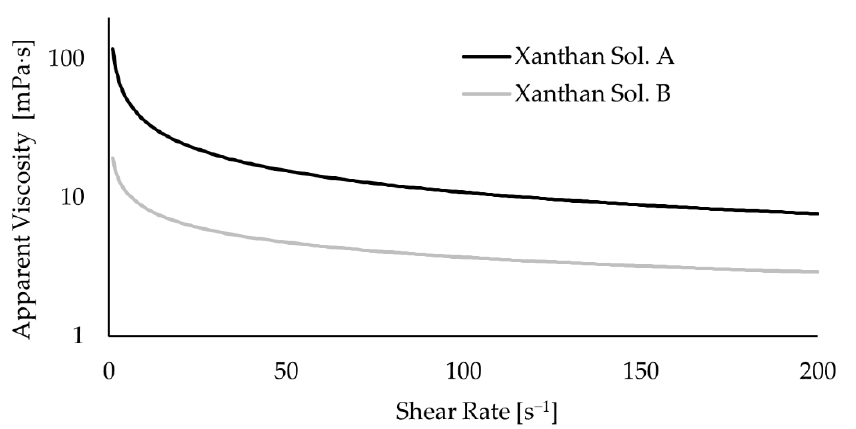
Figure A1. Shear rate versus apparent viscosity curve for the selected non-Newtonian fluids.